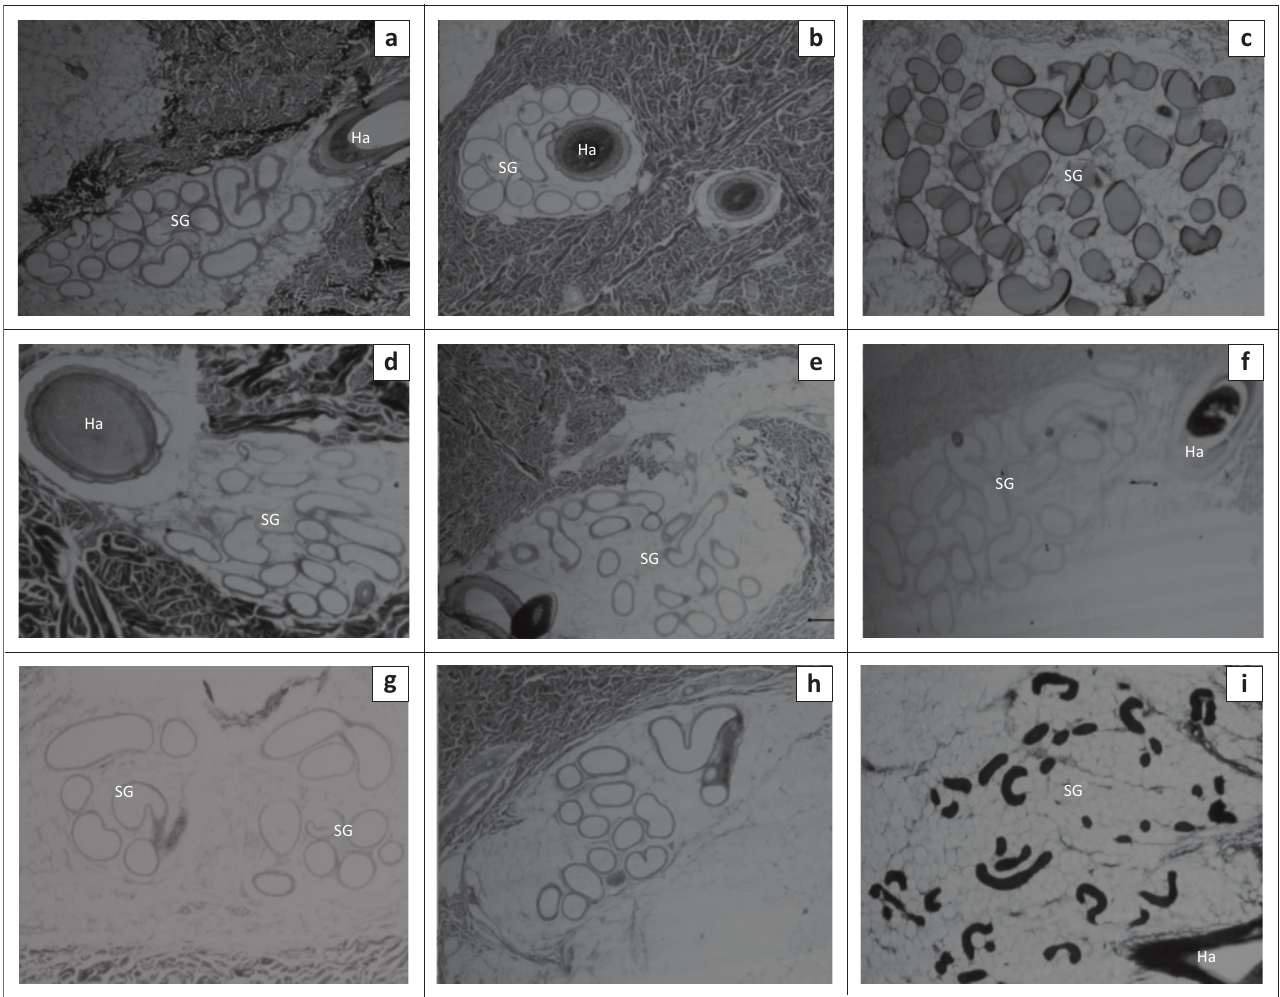
FIGURE 2: Representative skin sections from (a, b, c) the dorsal interscapular region, (d, e, f) lateral thoraco-abdominal region; and (g, h, i) ventral abdominal region of (a, d, g) Windsnyer, (b, e, h) Kolbroek and (c, f, i) Large White pigs showing the relative sizes of the sweat glands in the three body regions. (Sweat gland [SG] and hair follicle [Ha]) (Mallory–Heidenhain stain; objective: